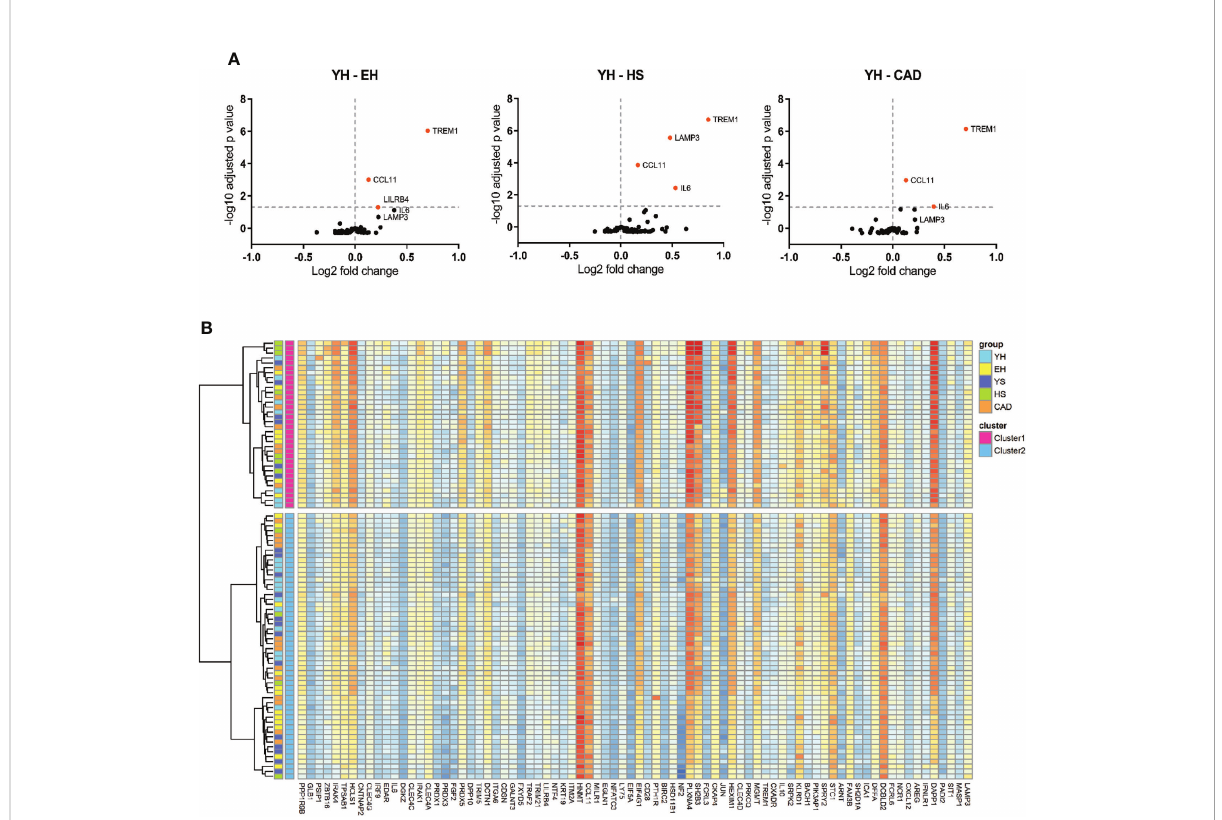
FIGURE 7 Effect of ageing and smoking on levels of circulating in fl ammatory proteins. Volcano plots of proteomics (A) , EH vs YH, HS vs YH and CAD vs YH. Horizontal line depicts signi fi cance, data points depicted in orange show increased serum expression. Heatmap of agglomerative hierarchical clustering using Ward ’ s method of proteomics data (B) . YH (n=19), EH (n=19), YS (n=19), HS (n=11), CAD (n=20). YH, young healthy; EH, elderly healthy; YS, young smoker; HS, heavy smoker; CAD, coronary artery disease